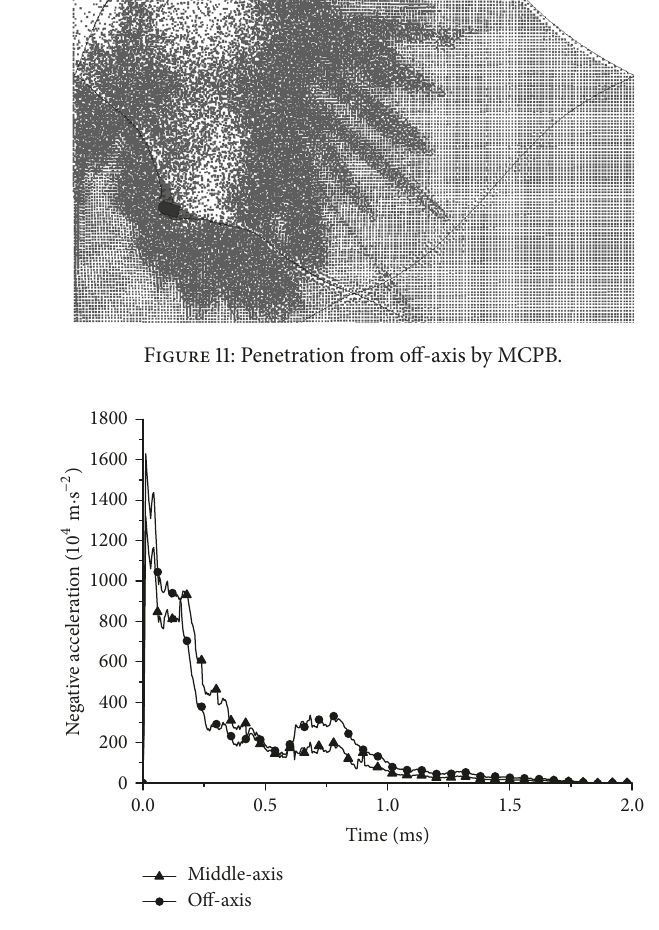
Figure 12: Negative acceleration of MCPB from different